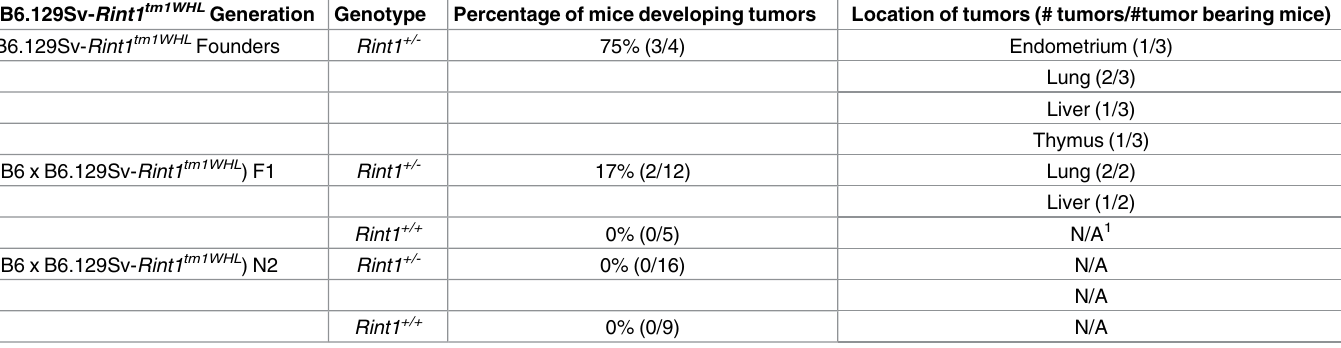
Table 2. Impact of Genetic Background on Spontaneous Tumorigenesis in Rint1 +/- mice.